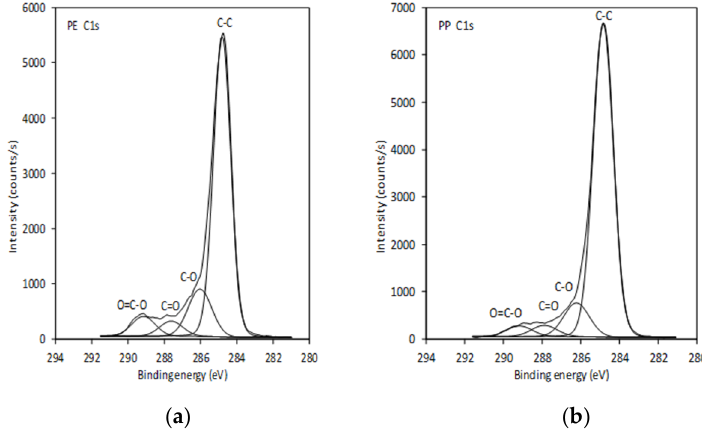
Figure 2. High resolution XPS spectra for: ( a ) PE-UV / O 3 ; ( b ) PP-UV / O 3 pretreated samples.